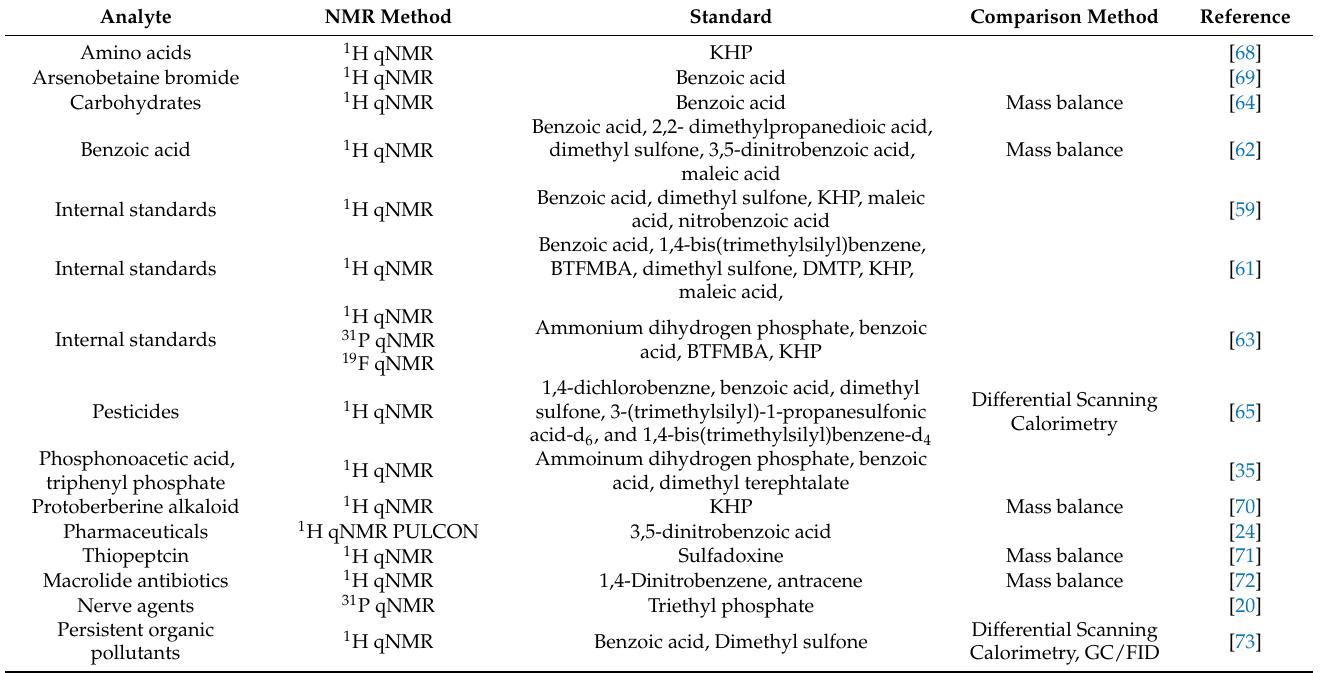
Table 1. Summary of reference materials analyzed by quantitative nuclear magnetic resonance (qNMR). Analyte NMR Method Standard Comparison Method